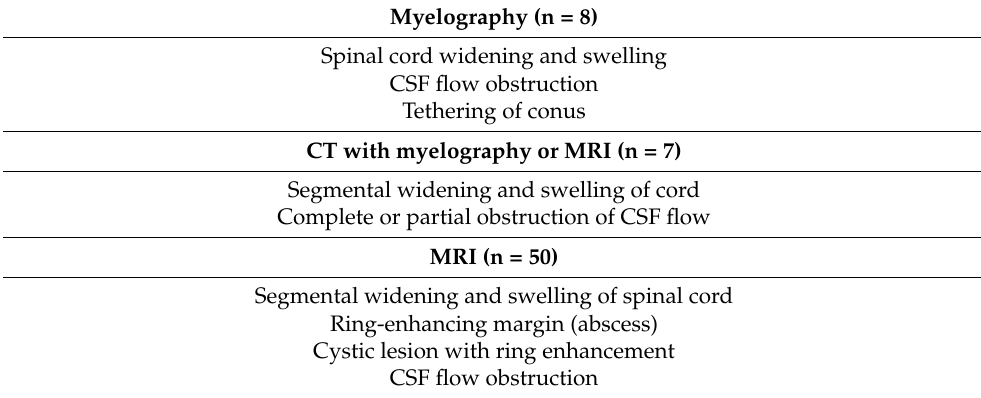
Table 2. Radiological features (myelography, CT, MRI) of intramedullary spinal cord abscess